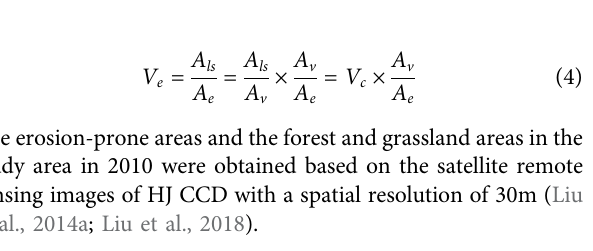
Frontiers in Earth Science |